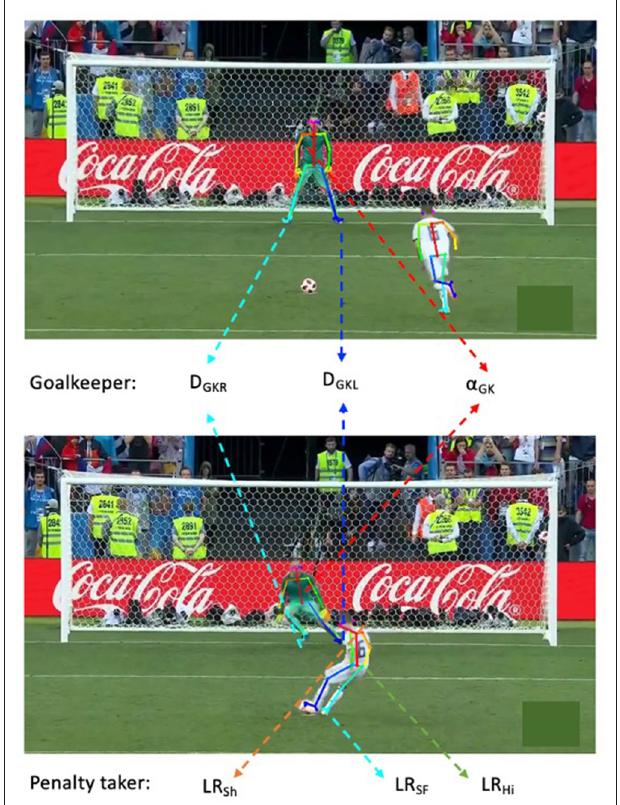
FIGURE 1 | Penalty kick viewing angle, frames analyzed, and process of pose estimation. The upper image corresponds to the moment when the penalty taker starts the run-up approaching the ball, and the down one corresponds to the moment when he touches the ball. The coordinates belonging to shoulders, hips, and non-kicking foot of penalty taker are mapped in a 2D field. LR-side Booleans (LR Sh , LR Hi , LR SF : penalty kicker’s shoulder, hips, and non-kicking foot orientation, respectively), angles ( α Sh α Hi , α SF : penalty kicker’s shoulder, hip, and non-kicking foot, respectively) and confidences (C Sh , C Hi , C SF : confidence score of the orientation of penalty kicker’s shoulder, hips and non-kicking foot, respectively). Coordinates belonging to the neck and hip of the goalkeeper at these two moments are mapped to a vector and the angle is calculated ( α GK ). D GKR and D GKL , the movement distance of right and left foot; C GK , represent confidence